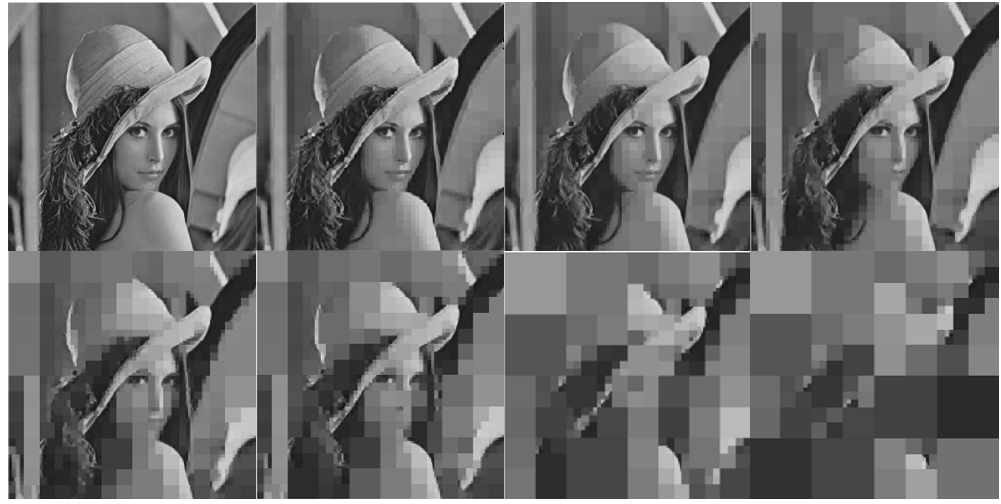
Figure 3 . Progressive effect of the decomposition factor R on the image